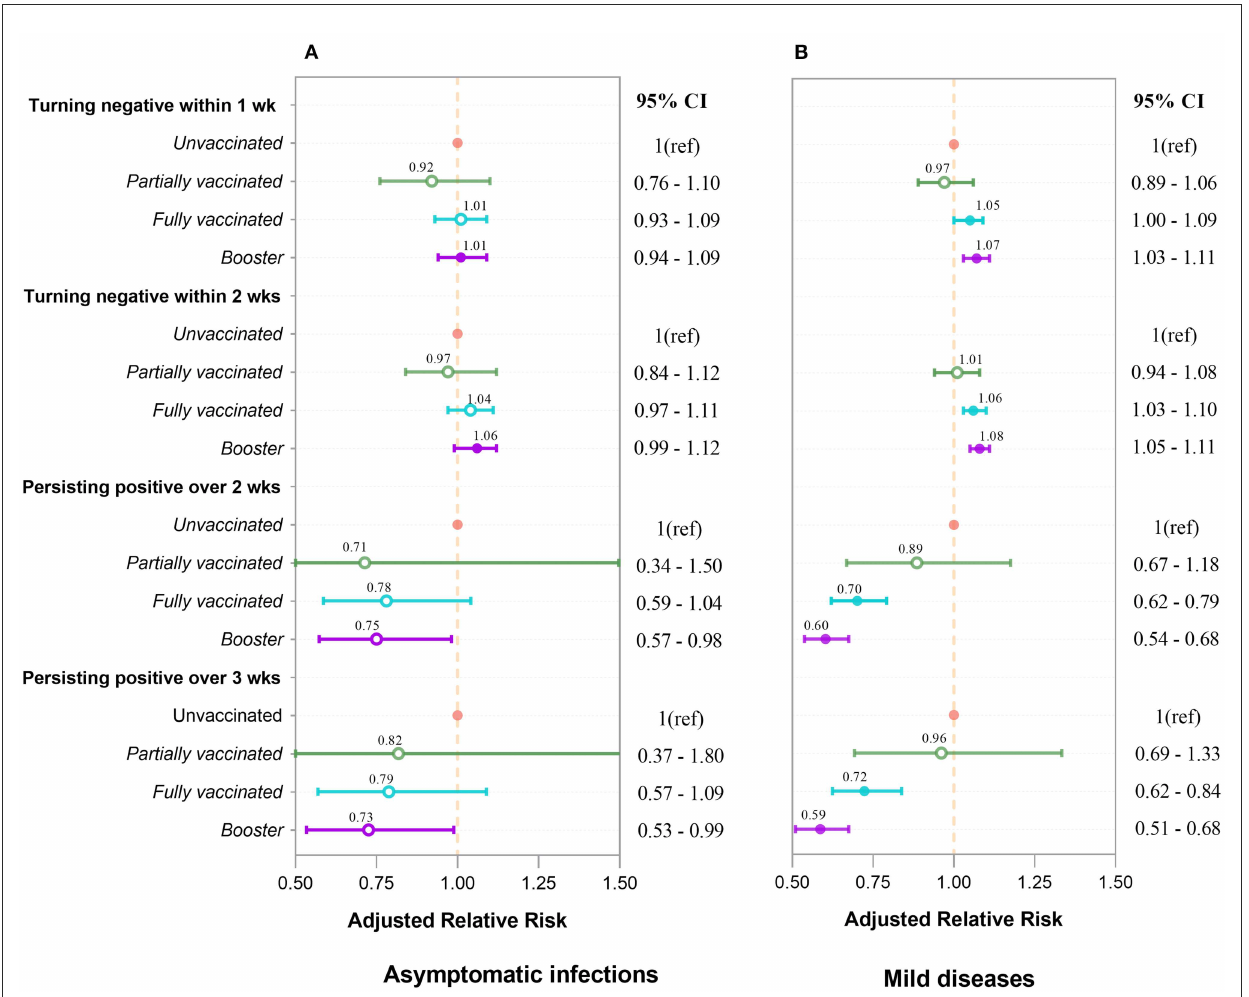
FIGURE3 Adjusted relative risk for turning negative and persisting positive associated with four types of vaccination in asymptomatic infections (A) and mild diseases (B) . aRRs were analyzed by Cox regression and logistic regression. Inactivated vaccines accelerate negative conversion and prevent persisting positive. The booster’s effect outperforms that of full vaccination, which outperforms that of partial vaccination. These effects are more pronounced and significant in mild diseases (B) than in asymptomatic infections (A) . Each point and interval in the figure represent the aRR and 95% confidence interval. Circles for points are filled if the value is significant ( P < 0.05), and open